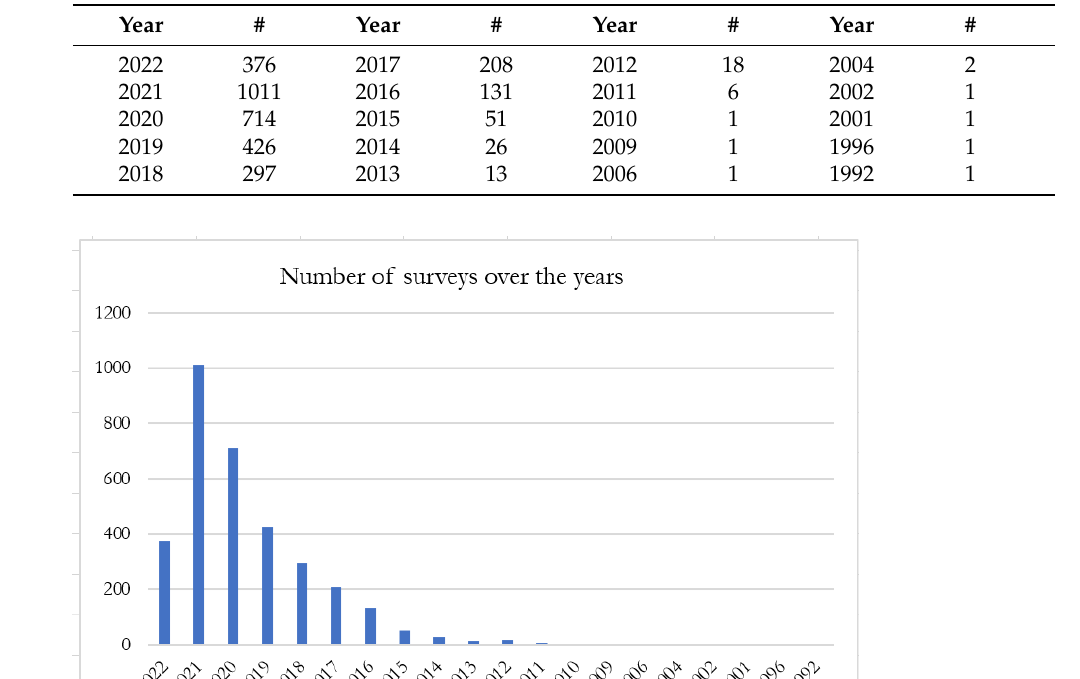
Table 1. Total number of reviews archived into Scopus.